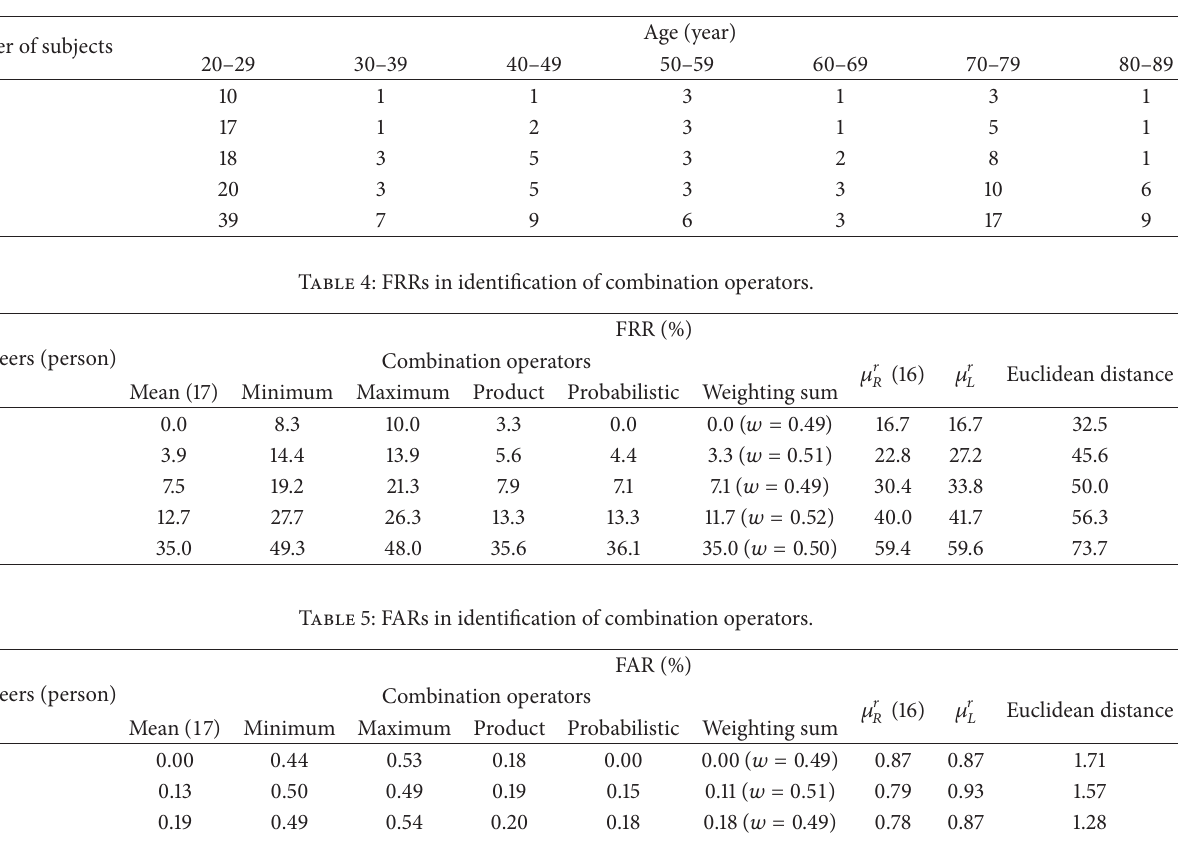
Table 3: Data set of performance test.